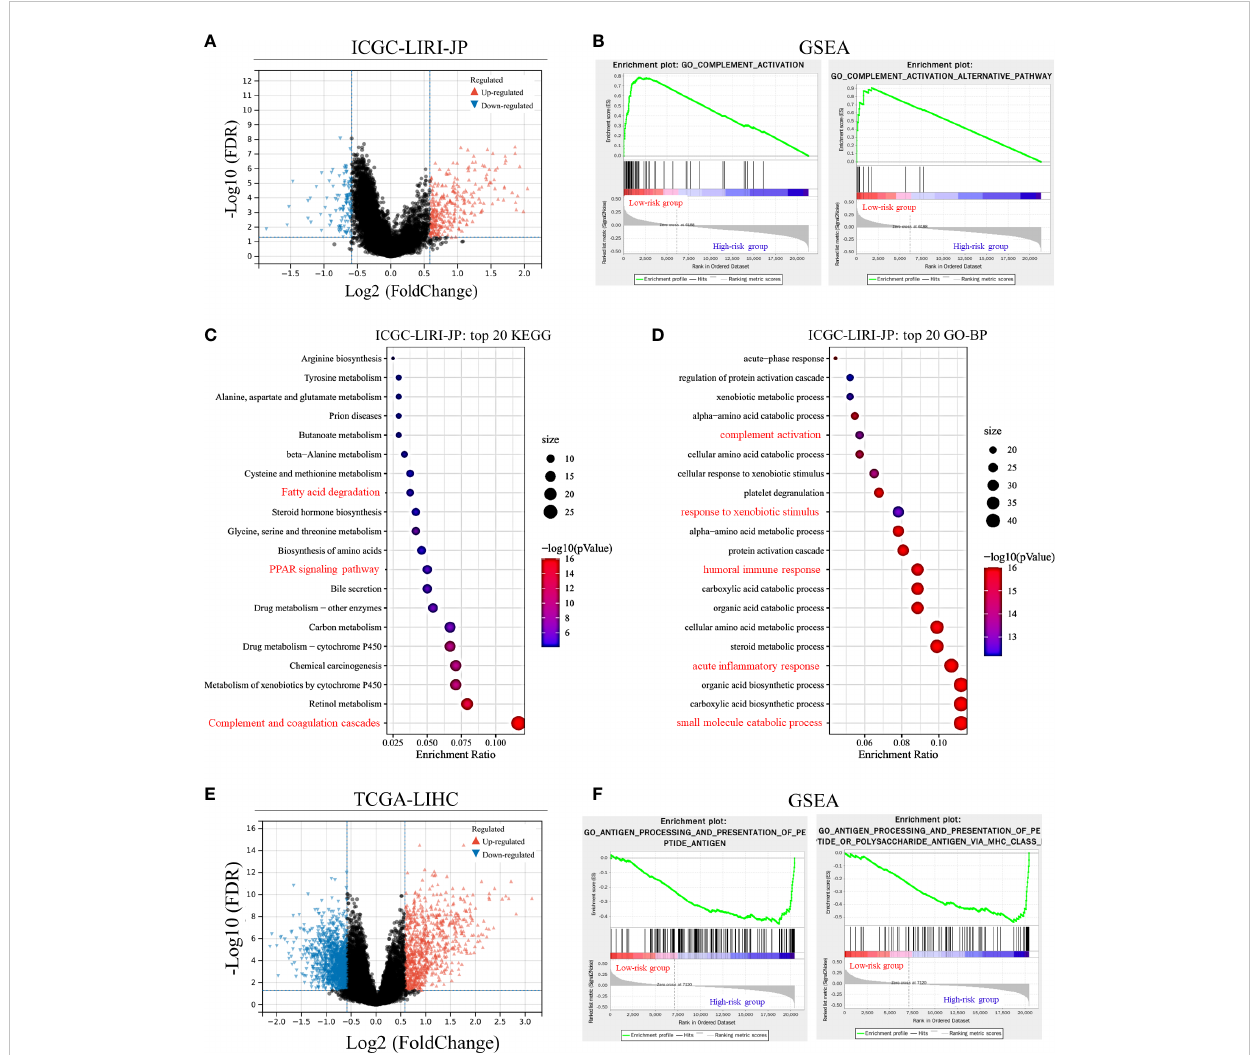
FIGURE 3 Differentially expressed gene (DEG) validation and potential pathway enrichment analysis. (A) Volcano plot of DEGs in the ICGC-LIRI-JP dataset. (B) Gene Set Enrichment Analysis (GSEA) of immune-related pathways in the ICGC-LIRI-JP dataset. (C, D) Top 20 enriched Kyoto Encyclopedia of Genes and Genomes (KEGG) pathways and Gene Ontology-biological process (GO-BP) pathways in the ICGC-LIRI-JP dataset. (E) Volcano plot of DEGs in the TCGA-LIHC dataset. (F) GSEA of immune-related pathways in the TCGA-LIHC